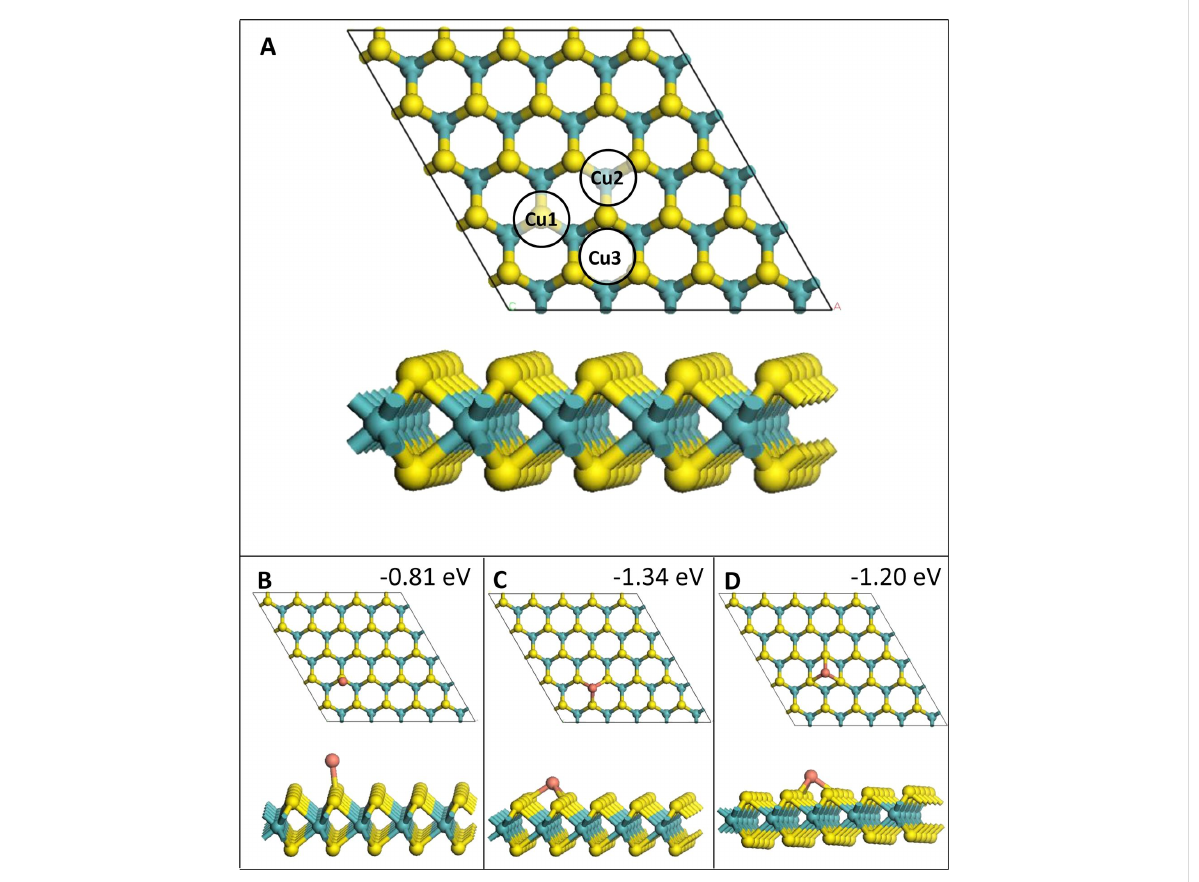
Figure 1: (A) Adsorption sites on a MoS 2 monolayer. (B–D) Relaxed structures after adsorption of one Cu atom on the monolayer at sites 1 , 2 and 3 , respectively. Yellow = S, teal = Mo, orange =